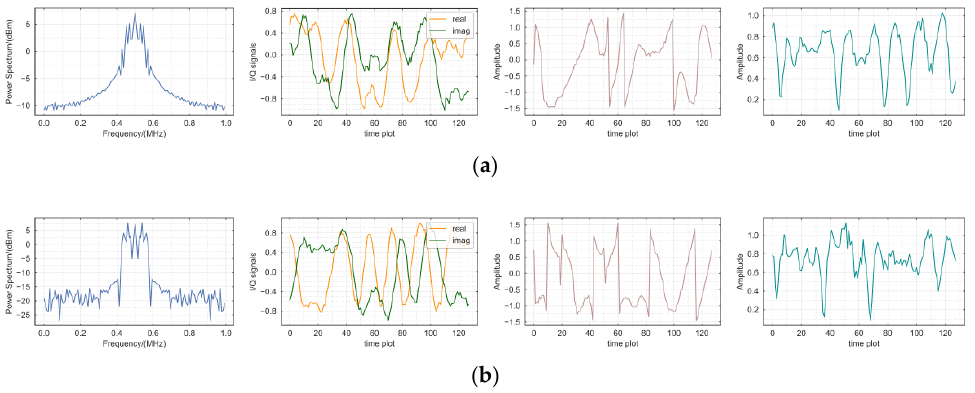
Table 6. Performance comparison for semi-supervised methods versus typical